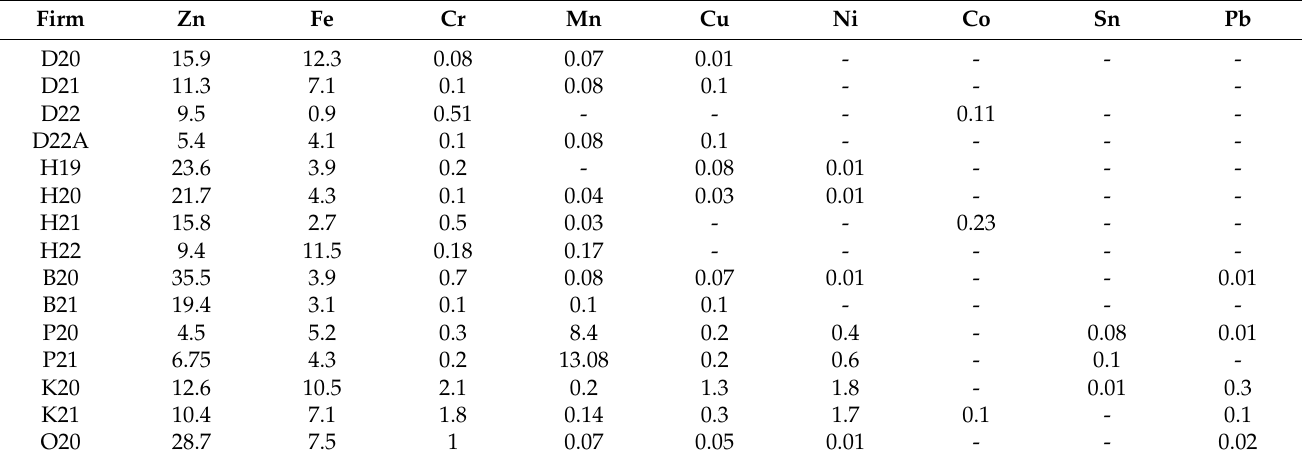
Table 2. Chemical analysis of the sludge delivered from 6 companies—ED-XRF